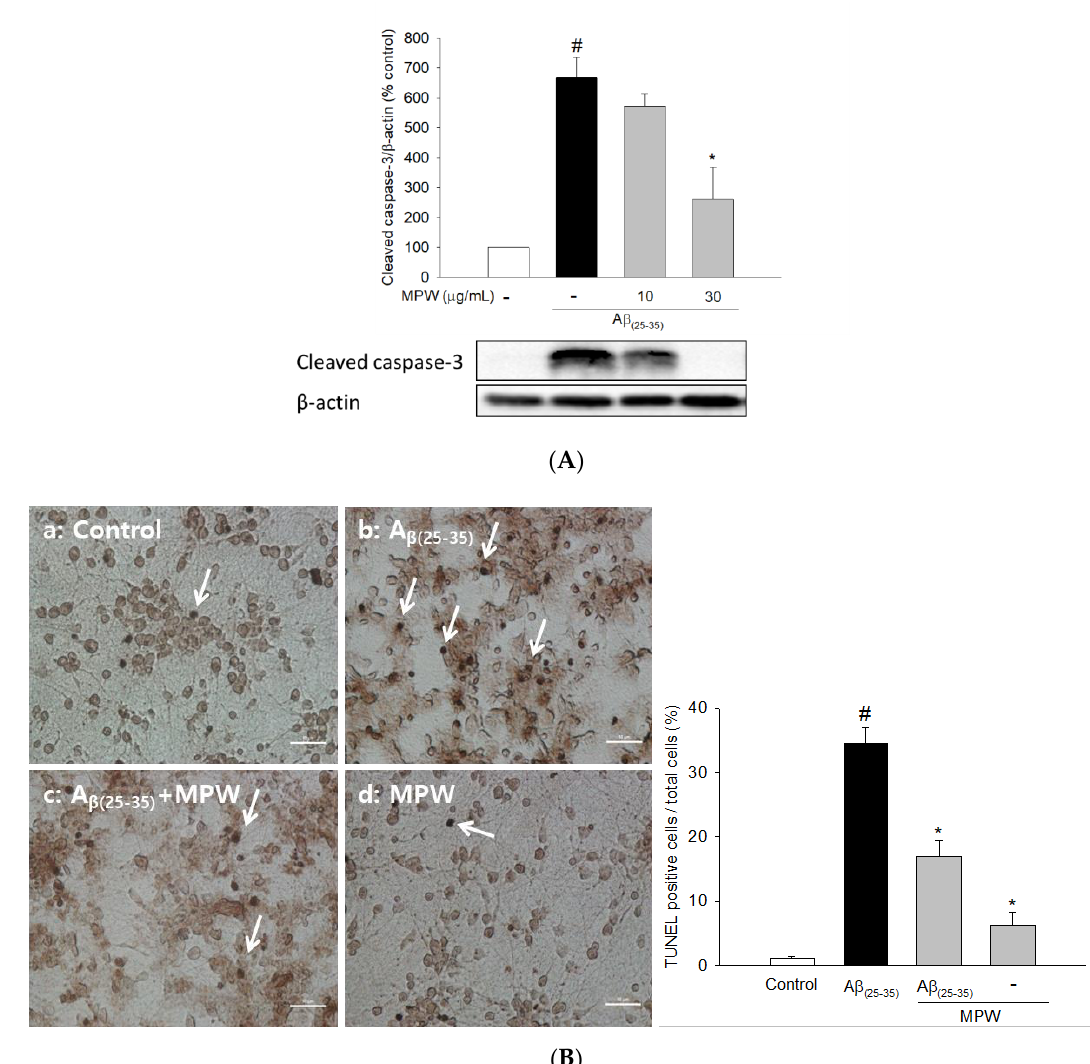
Figure 2. Effects of MPW on A β (25–35) -induced caspase 3 activation and DNA fragmentation in primary rat cortical cells. ( A ) The cultured cells were treated with 40 µ M A β (25–35) for 24 h in the absence or presence of MPW at 10 or 30 µ g/mL. The level of cleaved caspase 3 was assessed by Western blotting, as described in the Materials and Methods. A representative blot from three independent experiments is shown. ( B ) The cultured cells were treated with 40 µ M A β (25–35) for 2 h in the absence or presence of MPW at 30 µ g/mL, and the TUNEL assay was carried out as described in the Materials and Methods. Representative microscopic images from at least three independent experiments are shown. Cells were treated with the vehicle (a), A β (25–35) (b), A β (25–35) and MPW (c), or MPW alone (d), respectively. The representative TUNEL-positive cells are indicated by white arrows. Scale bar = 10 μm. Each data point represents the mean ± S.E.M. from at least three independent experiments (#, p < 0.05 vs. the vehicle-treated control cells without MPW; *, p < 0.05 vs. the A (25–35) -treated cells without MPW).